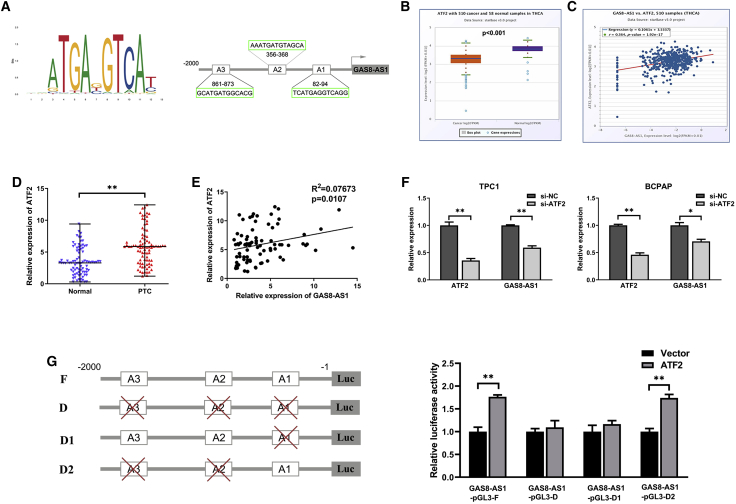
ATF2 Induced GAS8-AS1 Expression by Functioning as a TF(A) JASPAR predicted the positions of the putative ATF2 binding motif at −2,000 bp in the human GAS8-AS1 promoter. (B) GAS8-AS1 expression in PTC tissues and normal tissues from TCGA database. (C) Correlations between GAS8-AS1 and ATF2 in PTC tissues from TCGA database. (D) The relative expression level of ATF2 in 84 pairs of PTC tissues and adjacent non-cancerous tissues. Statistical differences were analyzed using the Wilcoxon signed-rank test; data are shown as the median and range. (E) Correlations between GAS8-AS1 and ATF2 in PTC tissues were analyzed using Pearson’s correlation. (F) The expression levels of GAS8-AS1 and ATF2 following si-ATF2 treatment in TPC1 and BCPAP cells. (G) Luciferase reporter assay performed following co-transfection of the full-length GAS8-AS1 promoter (GAS8-AS1-pGL3-F) or deleted GAS8-AS1 promoter fragments (GAS8-AS1-pGL3-D, GAS8-AS1-pGL3-D1, GAS8-AS1-pGL3-D2) with the ATF2 expression plasmid or blank vector in TPC1 cells. Luciferase activities were expressed as relative to that of the pGL3 vector. Statistical differences were analyzed using the independent samples t test; data are shown as the mean ± standard error of the mean based on three independent experiments. ∗p < 0.05, ∗∗p < 0.01.